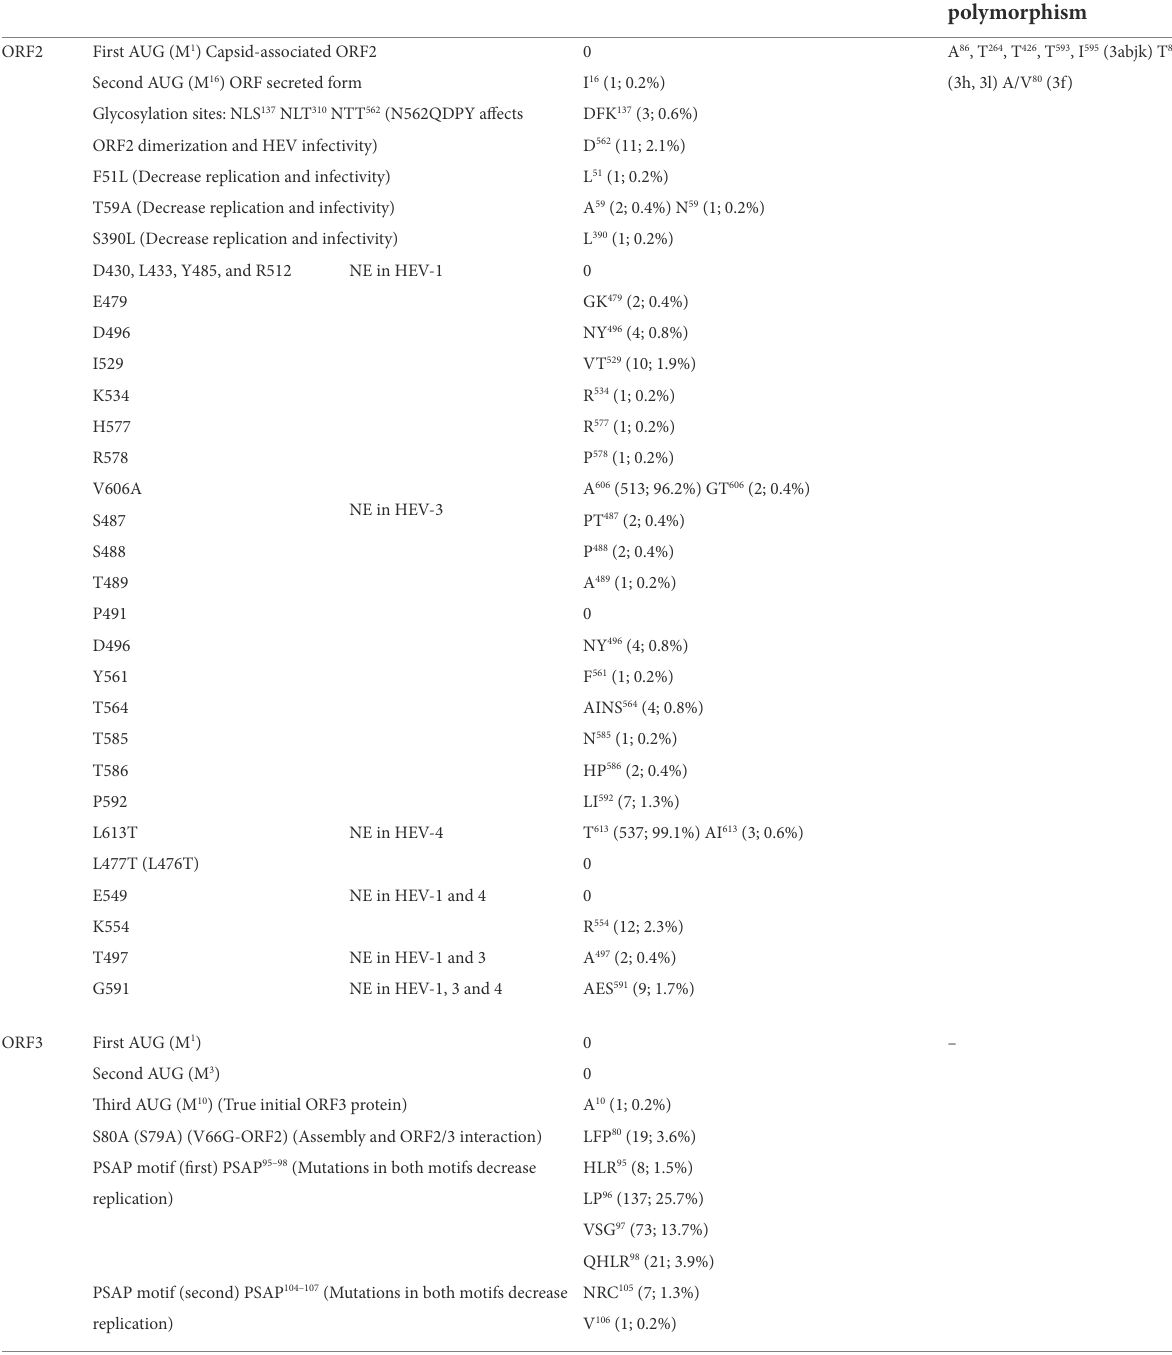
TABLE 3 Analysis of previously reported motifs, mutations and neutralization epitopes (NE) of ORF2 and ORF3 of HEV-3 genome (references of motifs and mutation are mentioned in the Introduction and listed in Supplementary material). Functional motif/mutation (Associated to) Substitutions sequences ( N ; %) Clade/subtype